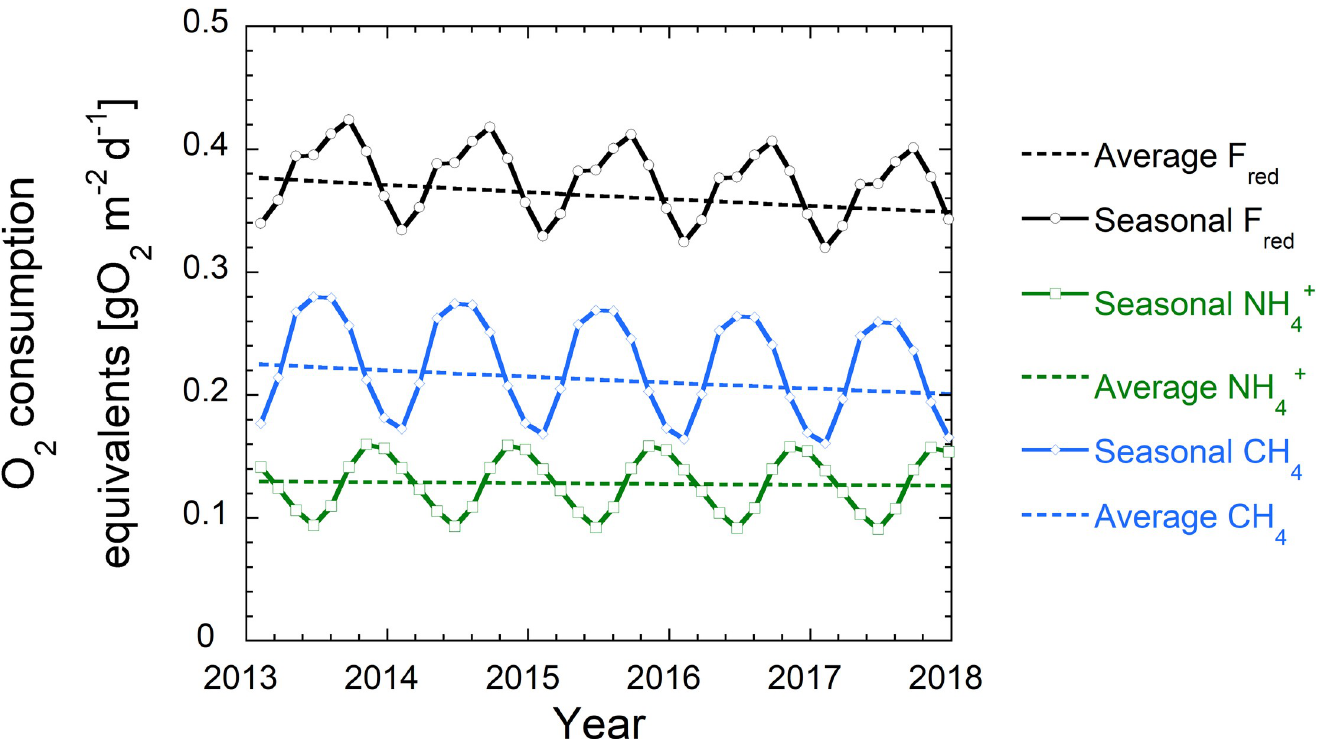
Fig 9. Modeled seasonal and average fluxes of CH 4 and NH 4+ expressed in O 2 consumption equivalents (F red ). While CH 4 fluxes (blue) decreased over time as less buried TOC was available for methanogenesis, NH 4+ fluxes (green) remained almost constant as they were dominated by the initial steps of anaerobic degradation. Seasonal fluxes of CH 4 and NH 4+ oscillated due to the seasonally changing prevalence of aerobic and anaerobic degradation.